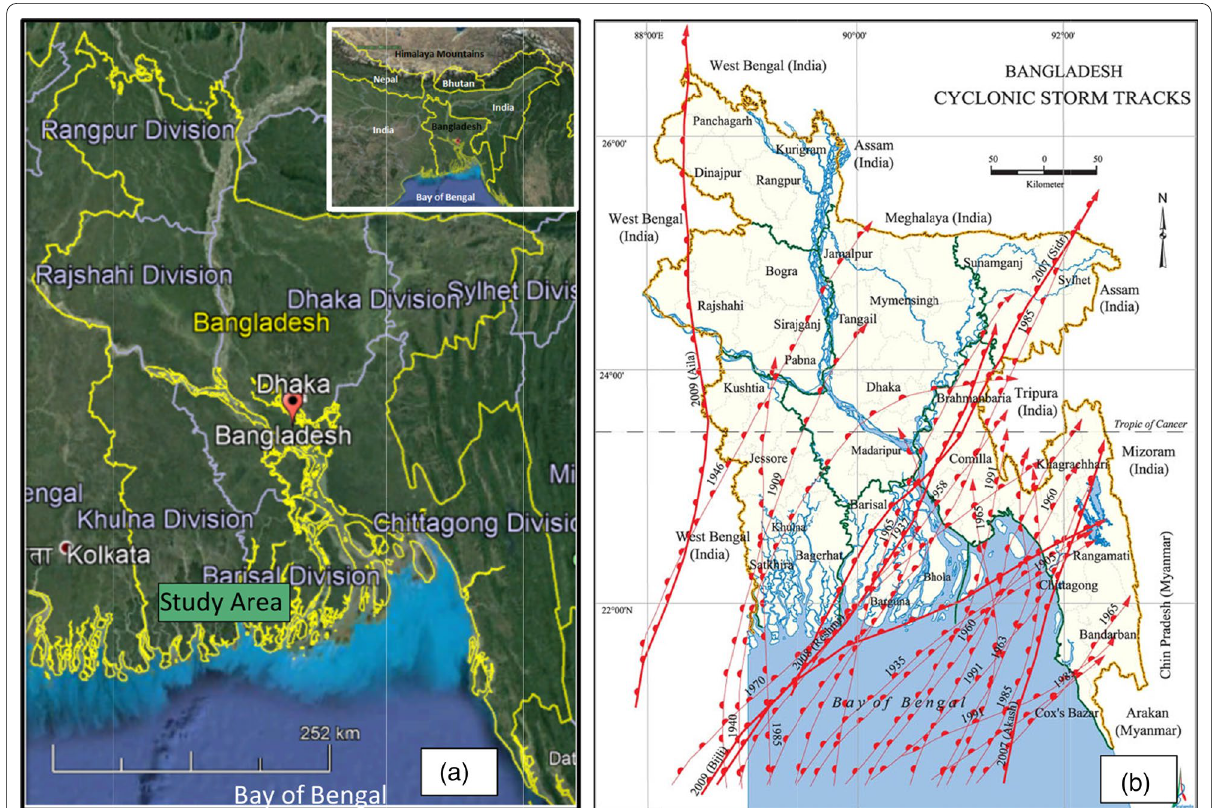
Fig. 3 a Location of study area in respect of Bangladesh and surrounding areas. b Cyclone track of Bangladesh. Source a Google Earth Pro, b